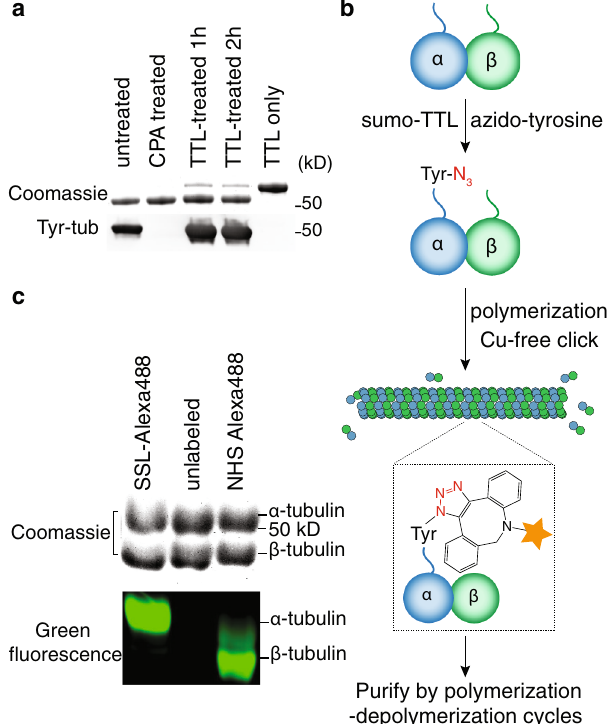
Fig. 1 Site-speci fi c functionalization of tubulin. a Recombinant tubulin- tyrosine ligase (TTL) increased the tyrosination of bovine-brain tubulin. The tyrosinated-tubulin level detected by antityrosinated tubulin antibody (clone YL1/2) increased after 1 h of incubation (bottom panel). Carboxypeptidase A (CPA) cleaves the C-terminal tyrosine of α -tubulin; CPA-treated tubulin therefore serves as a negative control. Experiments were repeated with duplicates. b Schematic process of the site-speci fi c labeling and puri fi cation of tubulin. The orange star represents the functional moieties of interest including fl uorophores, af fi nity tags (e.g.,